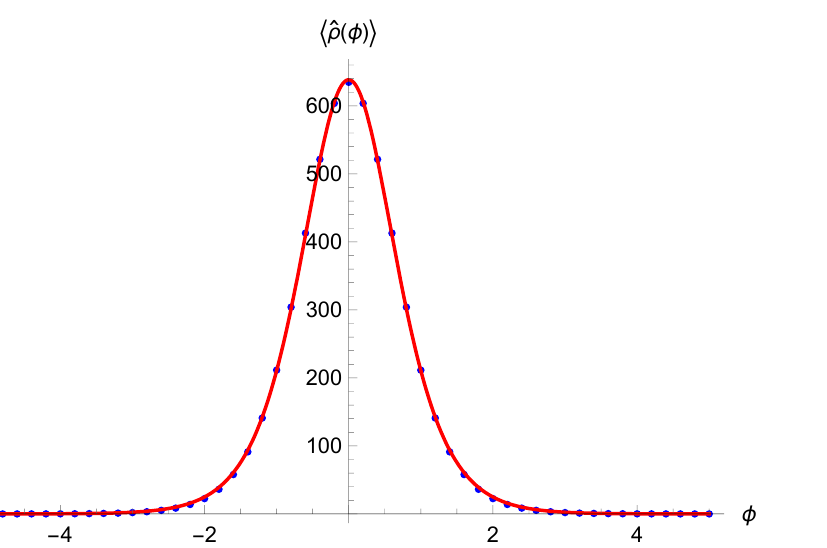
Figure 12. The expectation value of the energy density as a function of time (blue dots), fitted with a function in accordance with the semiclassical evolution (continuous red line).